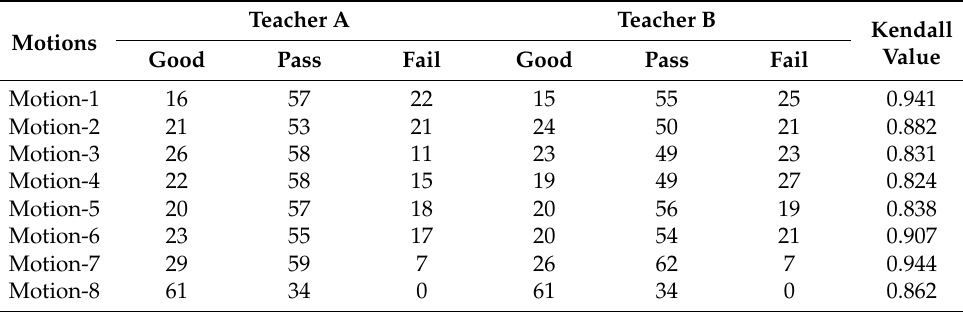
Table 2. The grading by two teachers and the Kendall correlation of the scores.